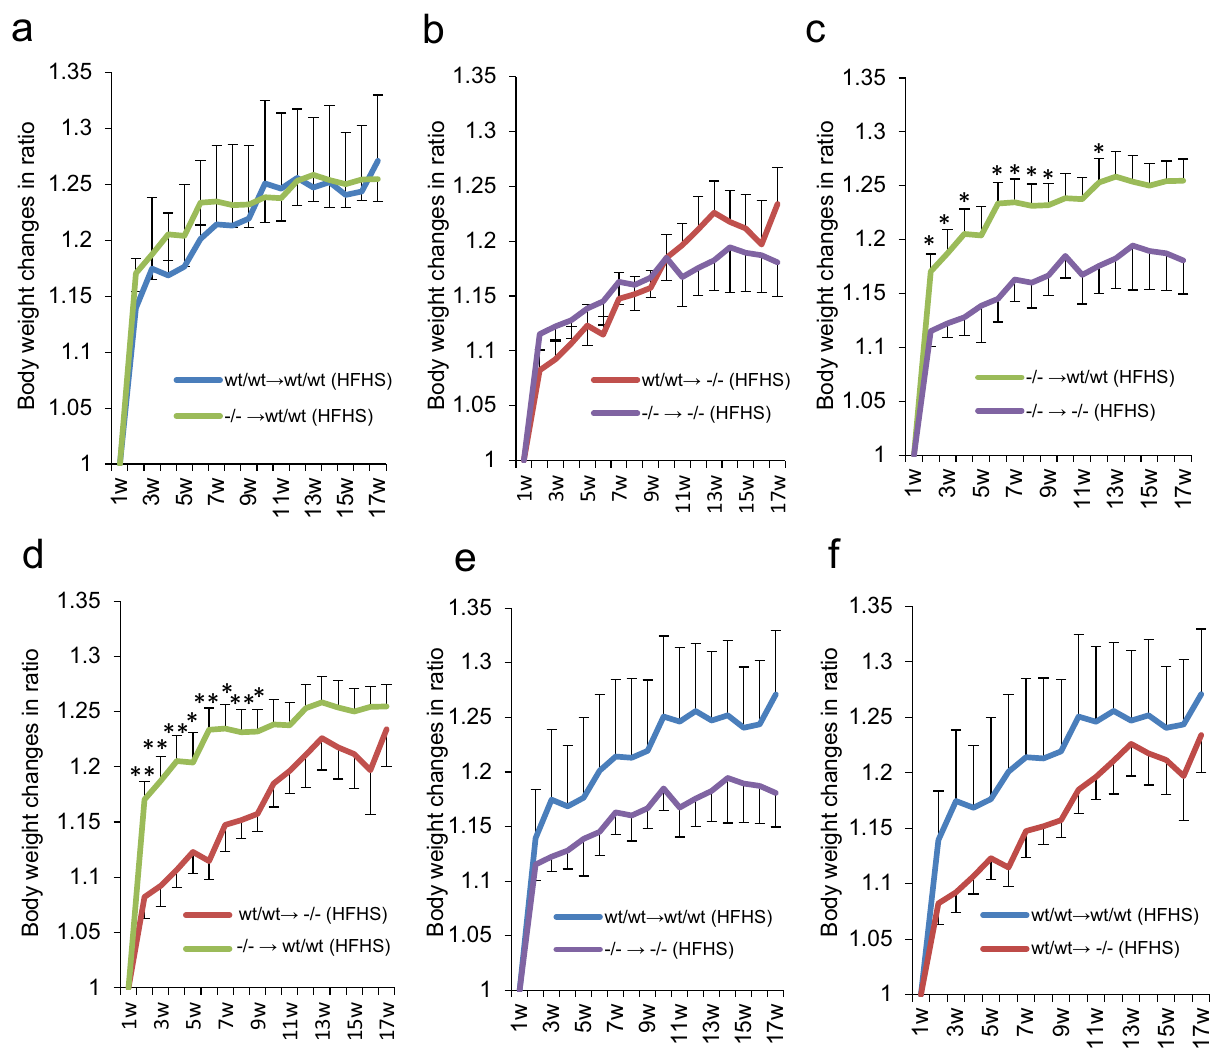
Figure 4. Body weight gain ratio in mice receiving bone marrow transplantation and fed with HFHS chow. The body weight at baseline is set as a reference. ( a ) WT → WT (n = 6), Gal-9 wt/wt (donors) and Gal-9 wt/wt (recipients); KO → WT (n = 8), Gal-9 −/− (donors) and Gal-9 wt/wt (recipients). ( b ) WT → KO (n = 7), Gal-9 wt/wt (donors) and Gal-9 −/− (recipients); KO → KO (n = 6), Gal-9 −/− (donors) and Gal-9 −/− (recipients). ( c ) KO → WT (n = 8), Gal-9 −/− (donors) and Gal-9 wt/wt (recipients); KO → KO (n = 6), Gal-9 −/− (donors) and Gal-9 −/− (recipients). ( d ) WT → KO (n = 7), Gal-9 wt/wt (donors) and Gal-9 −/− (recipients); KO → WT (n = 8), Gal-9 −/− (donors) and Gal-9 wt/wt (recipients). ( e ) WT → WT (n = 6), Gal-9 wt/wt (donors) and Gal-9 wt/wt (recipients); KO → KO (n = 6), Gal-9 −/− (donors) and Gal-9 −/− (recipients). ( f ) WT → WT (n = 6), Gal-9 wt/wt (donors) and Gal-9 wt/wt (recipients); WT → KO (n = 7), Gal-9 wt/wt (donors) and Gal-9 −/− (recipients). *, p < 0.05; **, p < 0.01. Two-pair comparisons by Student’s t